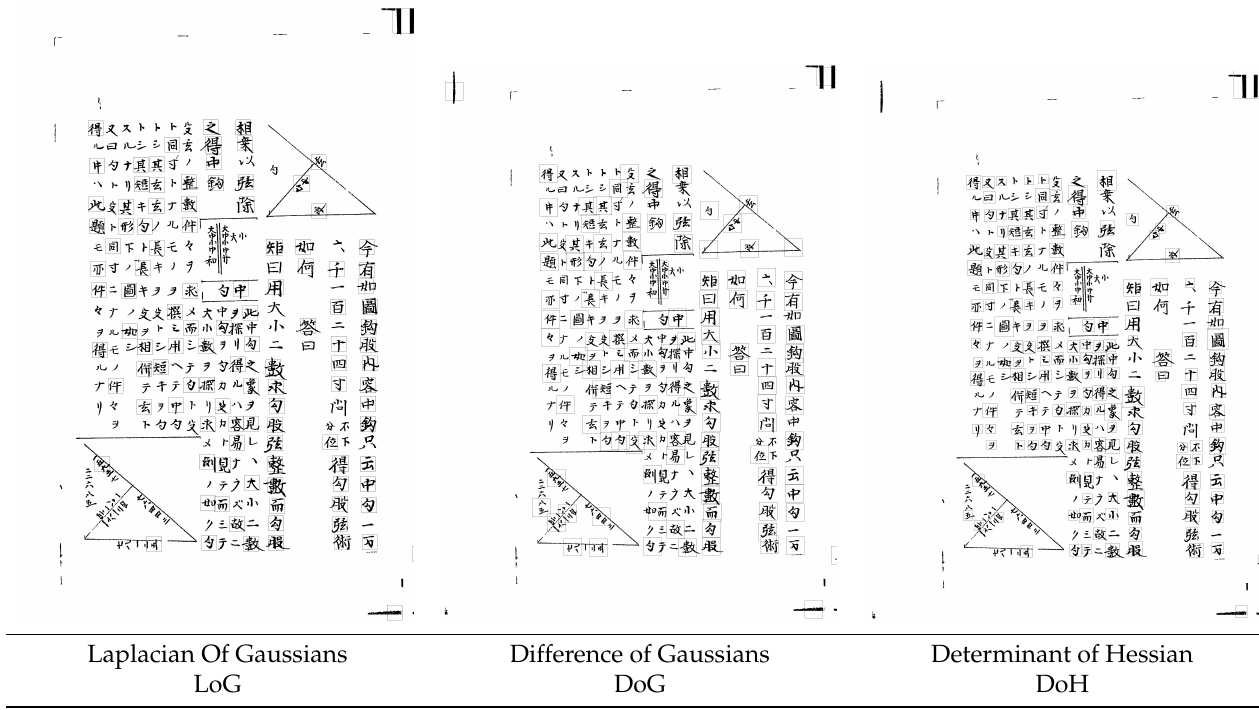
Laplacian Of Gaussians Difference of Gaussians Determinant of Hessian LoG DoG DoH Figure 7. Example results of the three blob detector methods used for kanji